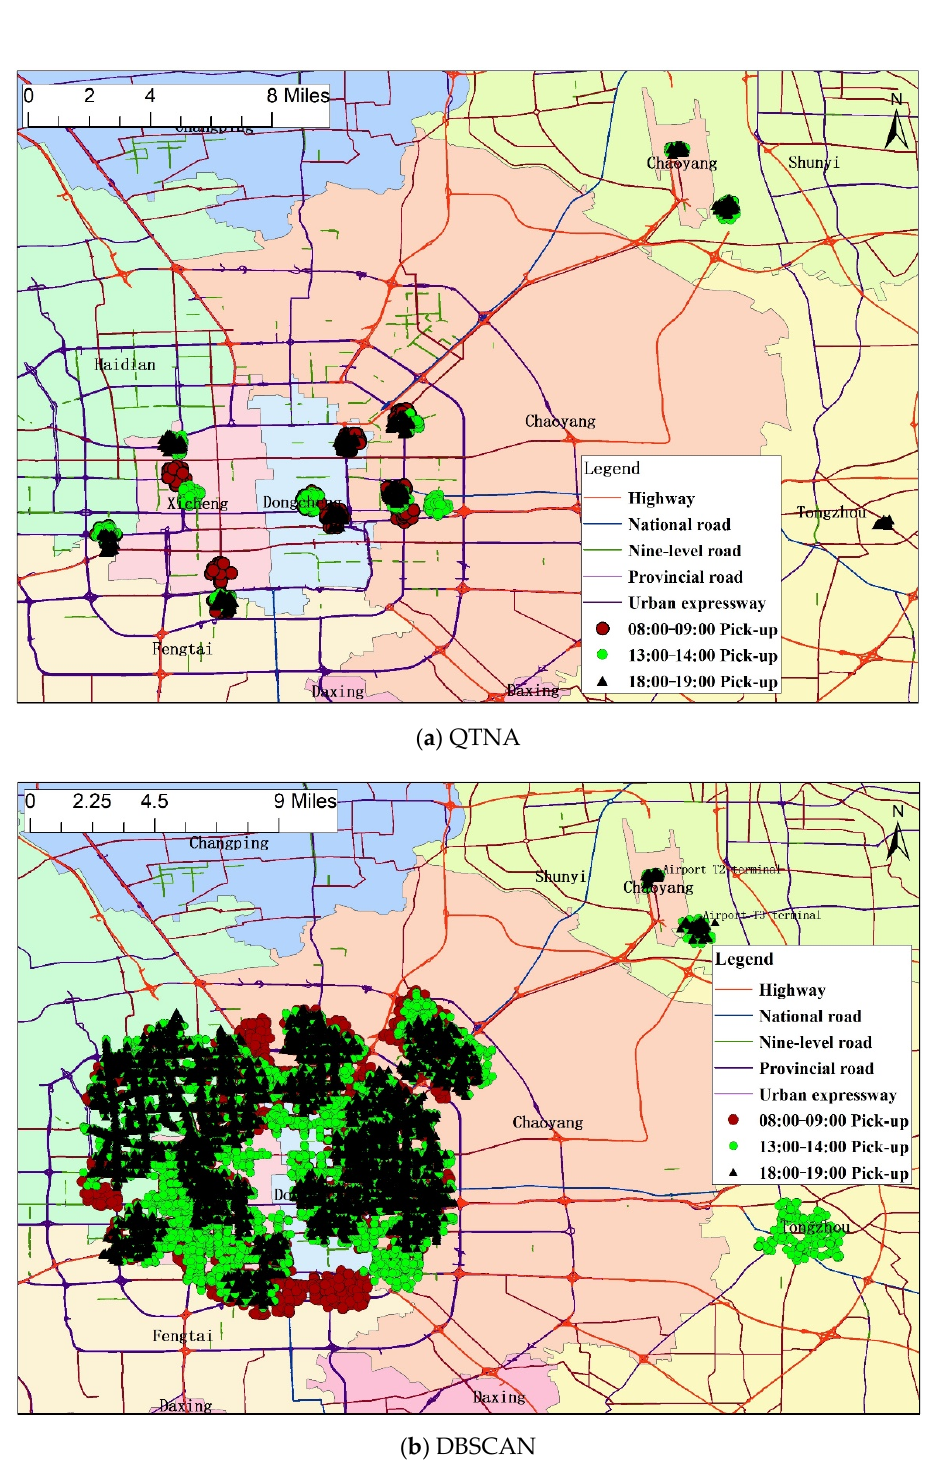
Figure 3. Top 10 hot pick-up areas during different periods on the same day. Some overlapping areas marked by different symbols are hot pick-up areas at different periods. ( a ) shows the detection results of the QTNA algorithm. ( b ) shows the detection results of the DBSCAN algorithm.